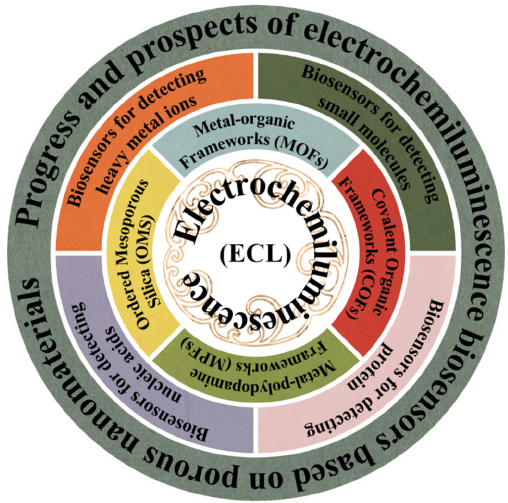
Figure 1. Schematics illustrating the application of ECL biosensors based on porous nanomaterials, as reviewed in this paper .